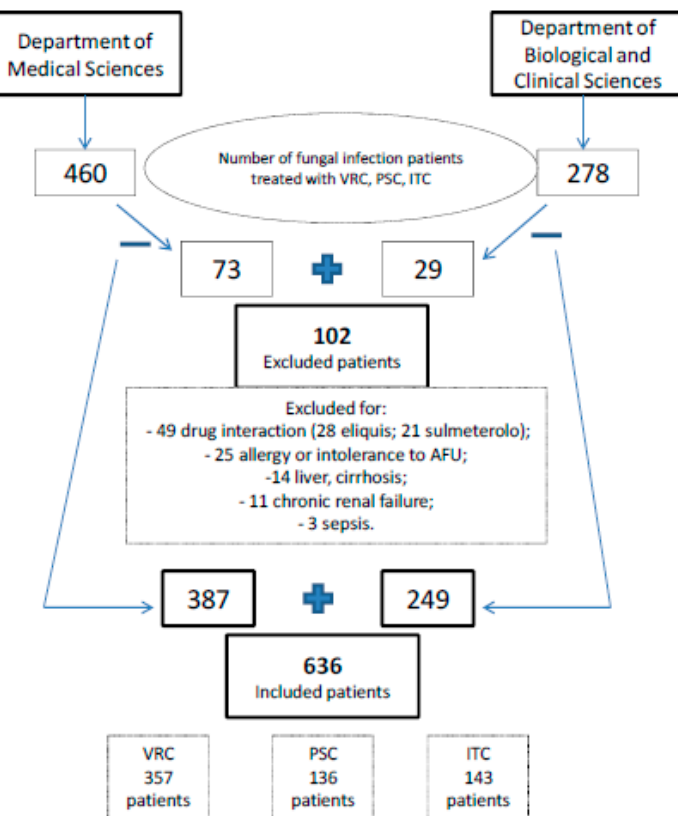
Figure 5. Diagram of patients enrolment considering inclusion and exclusion criteria.